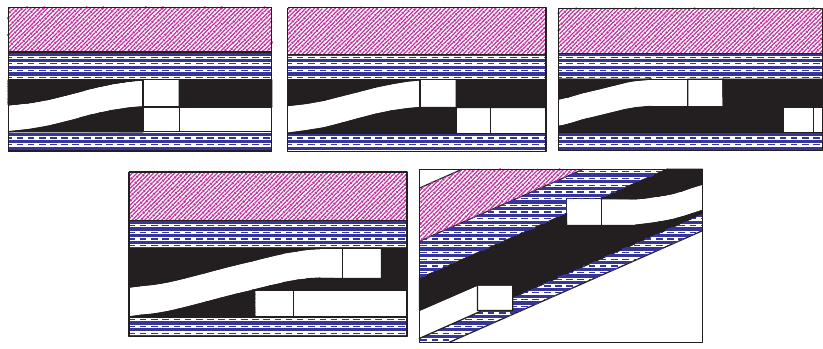
Figure 16: Other commonly used forms of SLL [32].